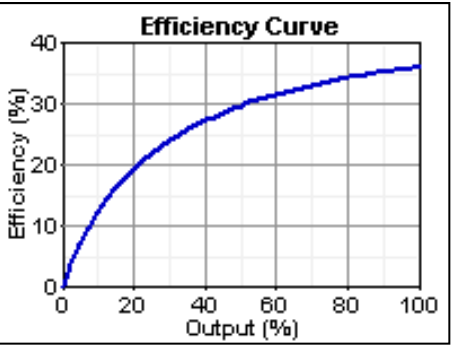
Figure 4. Diesel generator efficiency